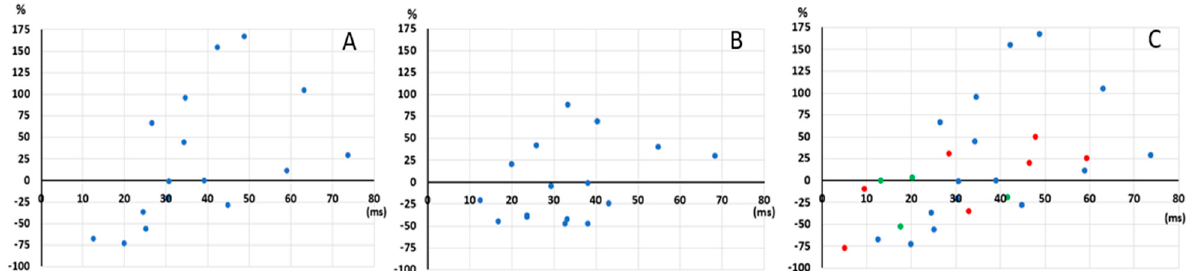
Figure 1. Comparison of pre-operative RMSSD values for each patient in the IOE group in the first part of the study ( A ), the TLE group ( B ), and the whole IOE group in the second part of the study ( C ) compared to its matched control. Each dot represents a patient. x -axis represent the pre-operative RMSSD of patients, y -axis represents the percentage of difference in RMSSD between patients (x) and their matched controls (c) [y = 100 ∗ (x − c)/c]. Insets A and B showed that the difference between IOE patients’ RMSSD from that of control seemed to be greater than in TLE patients. In inset C, blue dots represent IOE patients in the first part of the study, the green dots represent IOE patients with poor outcomes after surgery, and the red dots represent patients with temporo-insulo-opercular epilepsy. IOE = Insulo-opercular epilepsy; pNN50 = percentage of successive RR intervals that differ by more than 50 ms; RMSSD = root mean square of successive RR interval differences; SUDEP = sudden unexpected death in epilepsy.